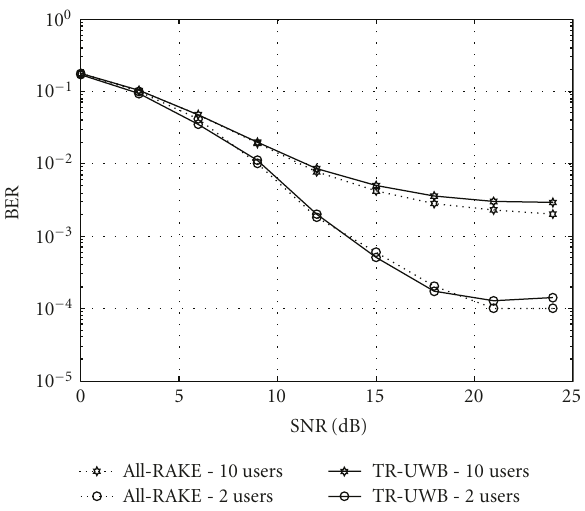
Figure 7: Similarity analysis of UWB and TR-UWB in the absence of ISI at 3Mbit/s, N s =